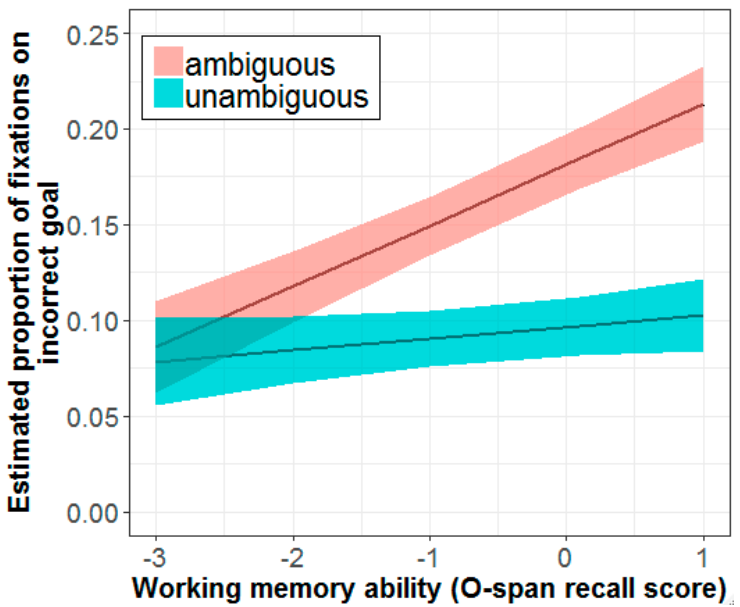
Figure 8. Estimated effect of working memory on incorrect-goal fixations for ambiguous sentences in bilinguals ( n = 23). More positive values on the x-axis indicate higher O-span recall scores. Shaded areas indicate standard error of the mean.